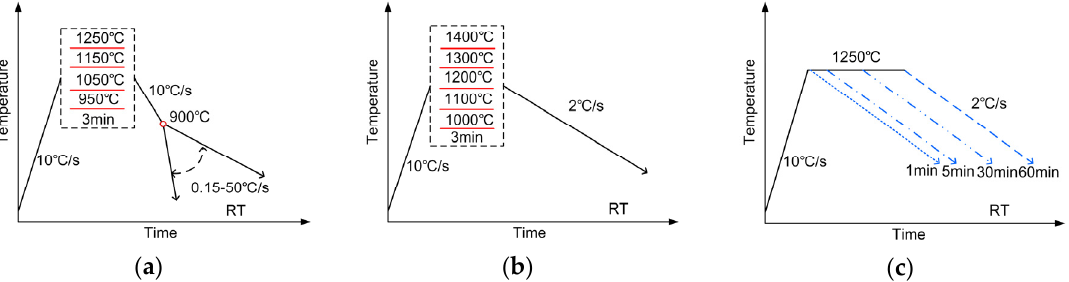
Figure 1. Schematic diagrams of thermal treatment processes for ( a ) continuous cooling transformation, ( b ) in situ observation and ( c ) austenitization